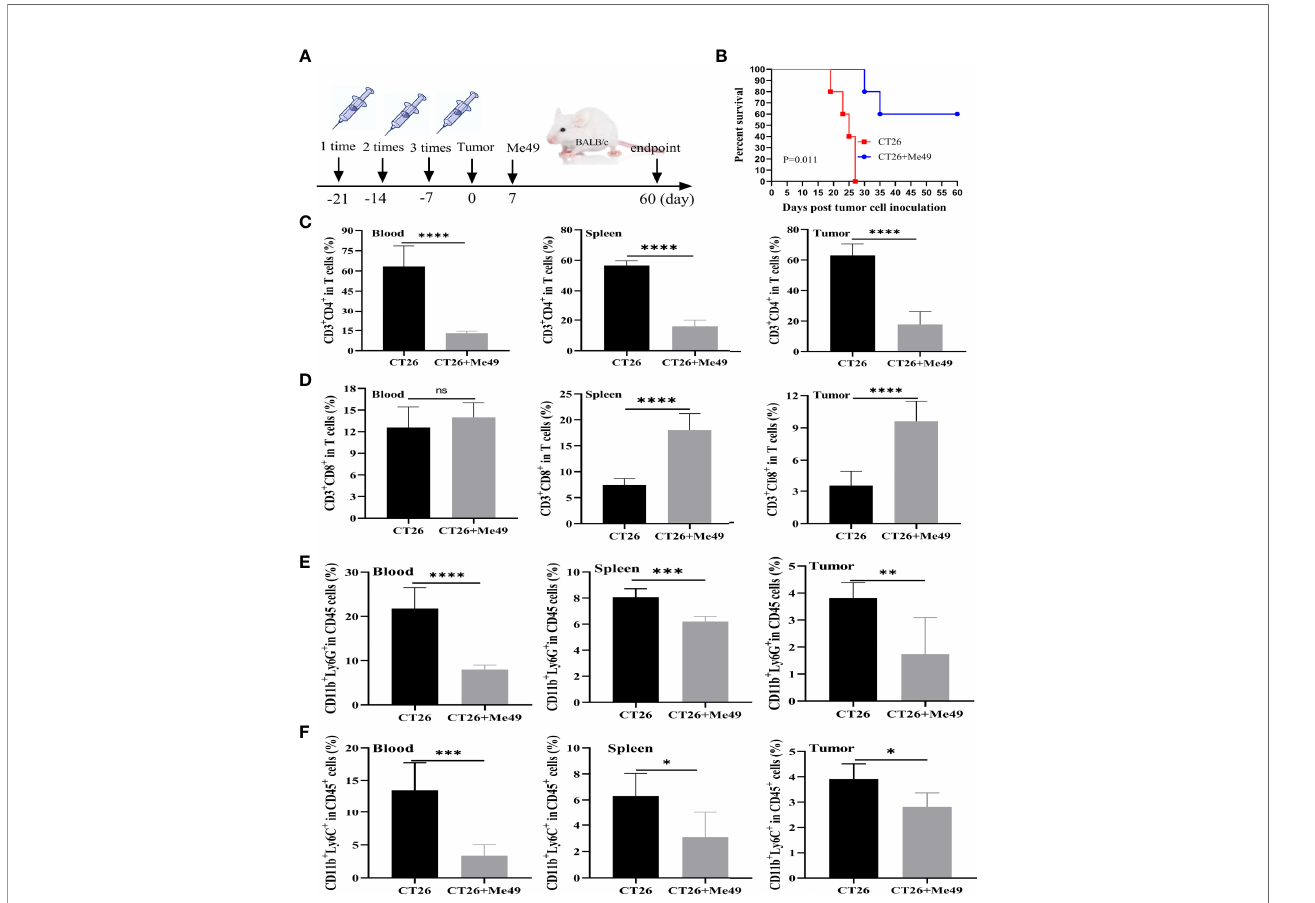
FIGURE 1 | T. gondii induced a protective immune response against tumor growth of CRC. (A) Mice were immunized with inactivated Me49 strain of T. gondii , and then vaccinated with CT26 cells. After 7 d, mice were reinfected with the Me49 strain of T. gondii . The control group was not infected after tumor inoculation (n = 5). (B) Survival rate of CT26 – bearing mice after T. gondii infection. FCM analysis of CD3 + CD4 + T cells (anti-CD3-FITC, anti-CD4-PB450) (C) , CD3 + CD8 + T cells (anti- CD3-FITC, anti-CD8-PE) (D) , G-MDSCs (anti-CD11b-FITC, anti-Ly6G-PE) (E) and M-MDSCs (anti-CD11b-FITC, anti-Ly6C-APC-A) (F) in peripheral blood, spleen and tumors from different groups. ns, ( p ≥ 0.05), * p < 0.05, ** p < 0.01, *** p < 0.001, **** p <